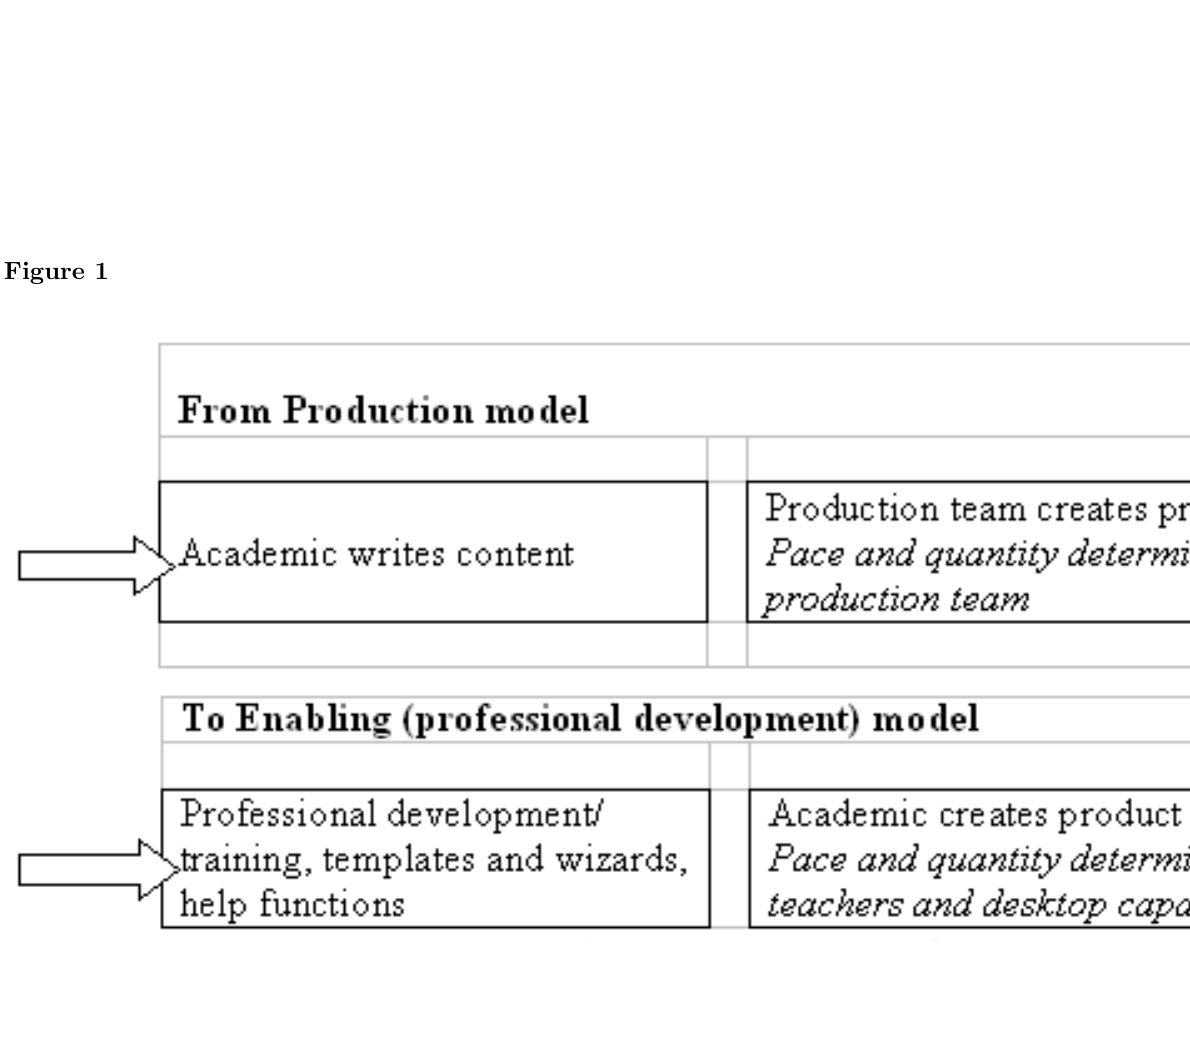
International Review of Research in Open and Distance